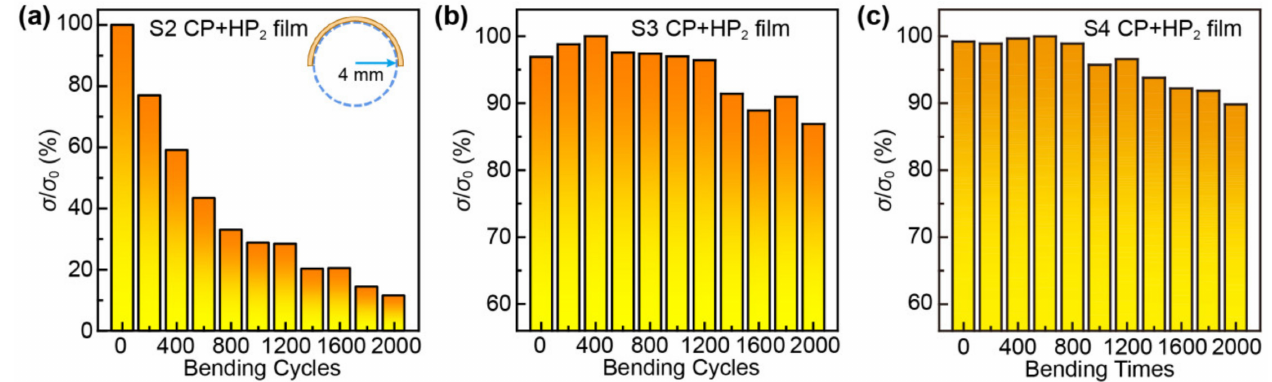
Figure 4. Flexibility property of the Ag 2 Se/nylon film. ( a – c ) The ratio of σ before and after bending as a function of bending times for the S2, S3 and S4 CP+HP 2 films,